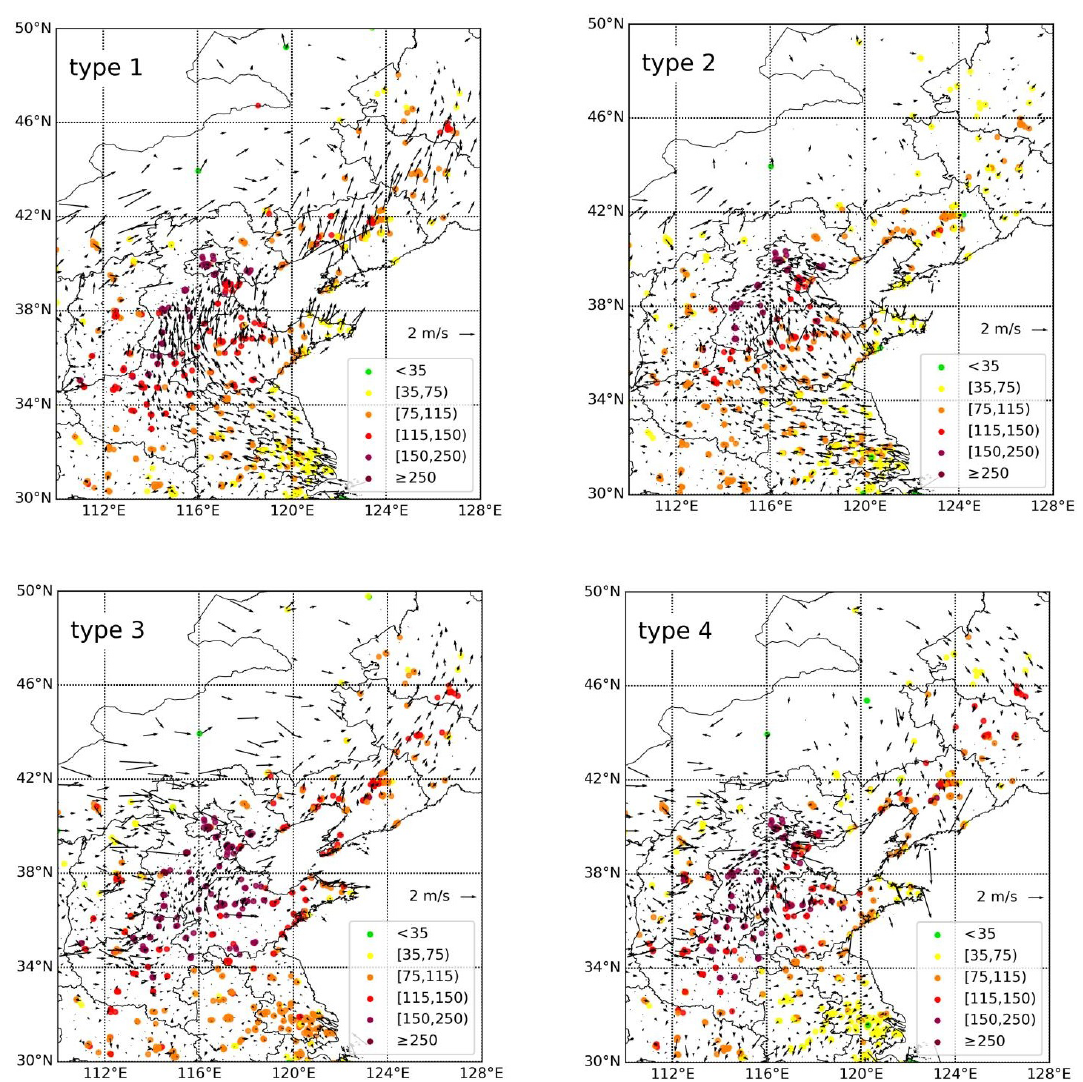
Figure 11. Spatial distribution of the PM 2 . 5 concentration (unit: µgm − 3 ) and wind field near the ground.